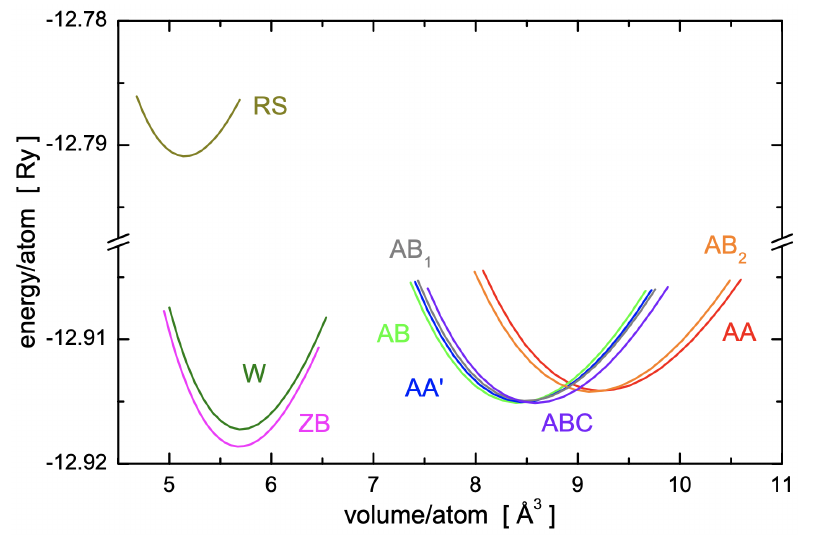
Figure 3. The energy per atom vs. volume per atom computed for nine different structures of boron nitride: rocksalt (RS), wurtzite (W), zincblende (ZB), and the six indicated